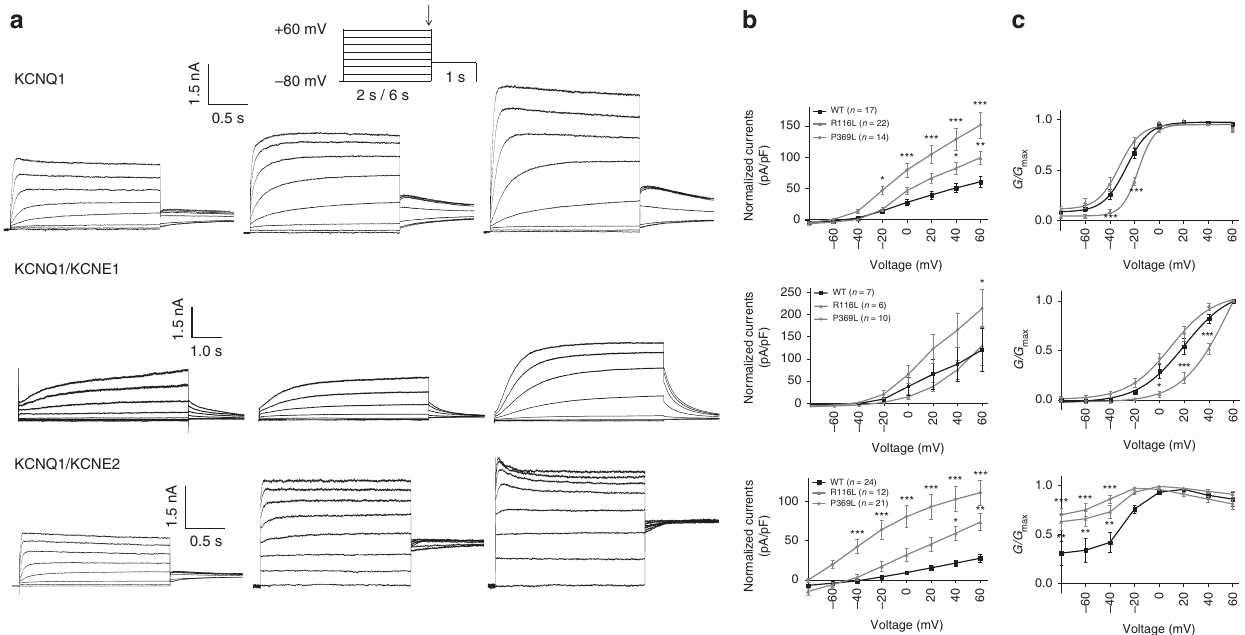
Fig. 2 Electrophysiological studies of the WT, KCNQ1-Arg116Leu and KCNQ1-Pro369Leu mutant KCNQ1 proteins. a Representative recordings of currents measured during the voltage-clamp protocol (shown in inset with scale bars) in HEK293 cells transfected with cDNAs encoding wild-type (WT) or mutant (p.Arg116Leu, p.Pro369Leu) KCNQ1 potassium channels: KCNQ1 alone (top row), KCNQ1 and KCNE1 (middle row), or KCNQ1 and KCNE2 (bottom row). b Respective current-voltage relationships normalized for cell size. Peak current analysis was performed at the end of each voltage step. pA/pF: picoamperes per picofarad. c Normalized activation curves, measured 2 – 4 ms after stepping to − 30 mV, as a function of the prior voltage potential. KCNQ1 and KCNQ1/KCNE1 conductance-voltage relation values were fi tted to a Boltzmann function. The time constants and slope values were; KCNQ1 WT: − 26.2 ± 2.9 mV, 8.6 ± 0.9 ( n = 14/3), KCNQ1-R116L: − 16.1 ± 1.5 mV, 6.9 ± 0.3 ( n = 21/4), KCNQ1-P369L: − 30.9 ± 2.5 mV, 6.9 ± 0.6 ( n = 14/3), KCNQ1 WT+KCNE1: 21.0 ± 2.5 mV, 16.2 ± 1.7 ( n = 18/3), KCNQ1-R116L+KCNE1: 42.4 ± 3.6 mV, 12.7 ± 1.7 ( n = 11/2), KCNQ1-P369L+KCNE1: 7.3 ± 3.8 mV, 14.7 ± 0.6 ( n = 18/3). Mean ± SEM values are shown. * P < .05, ** P < .01, *** P < .001 vs. WT. G / G max : conductance of the channel relative to